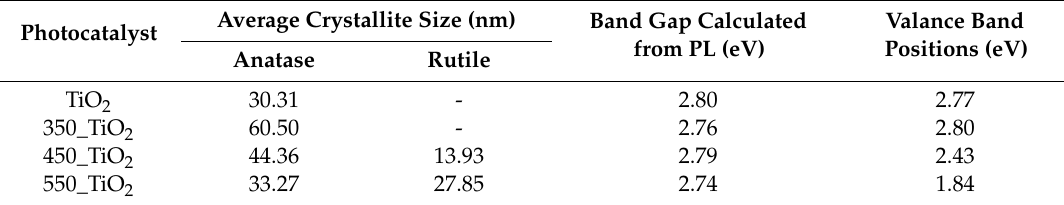
Figure 7. The effect of calcination temperatures on ( a ) the PL spectra and ( b ) the valance band of TiO 2 NTs. positions of TiO 2 NTs. Table 1. Crystallite size, inner tube diameter, and bandgap of the TiO 2 photocatalyst from di ff erent characterization